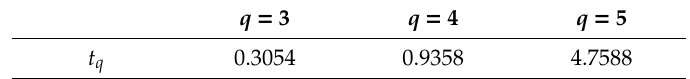
Table 1. The coe ffi cient of bearing boundary deflection t q for ball bearing